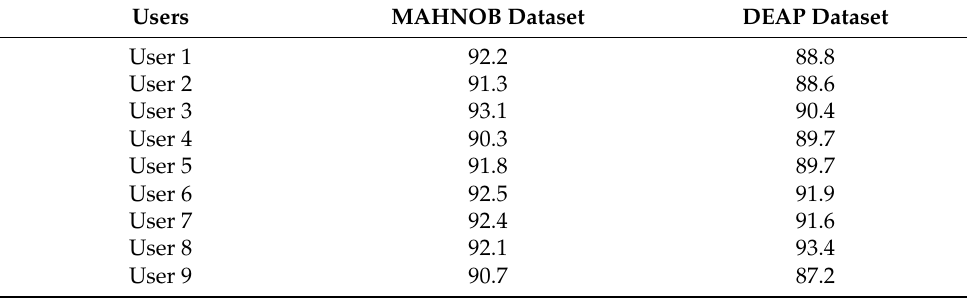
Table 4. Facial video clip based results in terms of accuracy